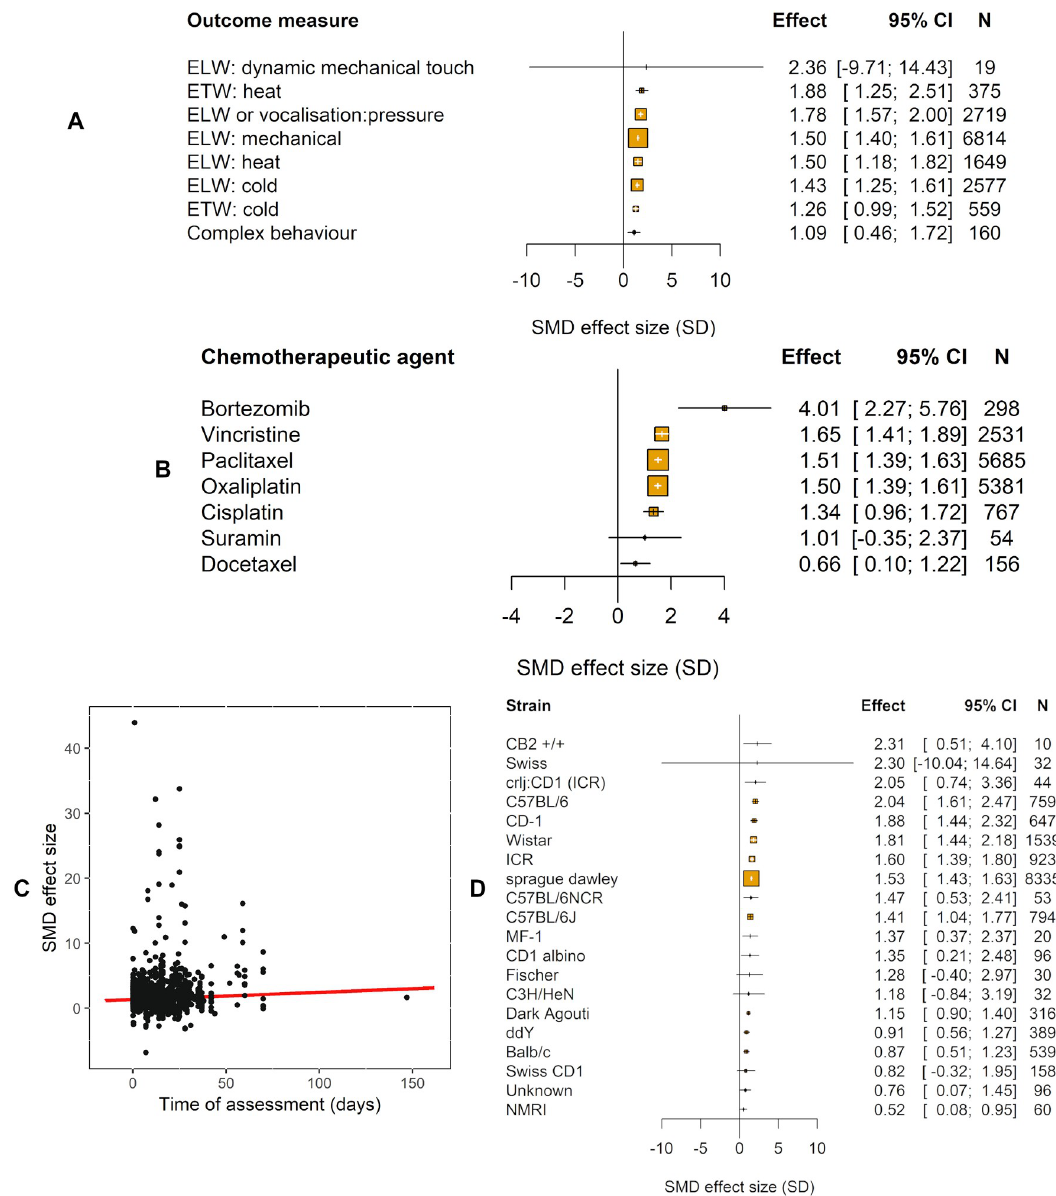
Fig 10. Impact of study design in intervention experiments using pain-related behavioural outcomes (data set 2a). The size of the squares represents the number of nested comparisons that contribute to that data point, and the value N represents the number of animals that contribute to that data point. (A) Outcome measure accounted for a significant proportion of the heterogeneity. (B) Chemotherapeutic agent accounted for a significant proportion of the heterogeneity. (C) Time of assessment accounted for a significant proportion of the heterogeneity. (D) Strain accounted for a significant proportion of the